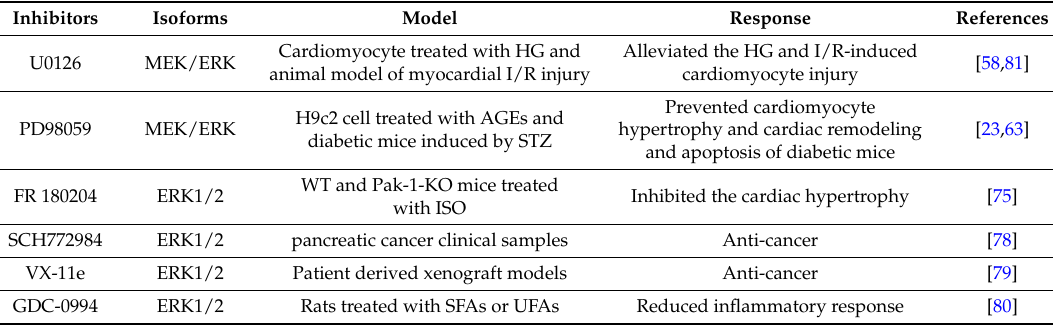
Table 1. Inhibitors of